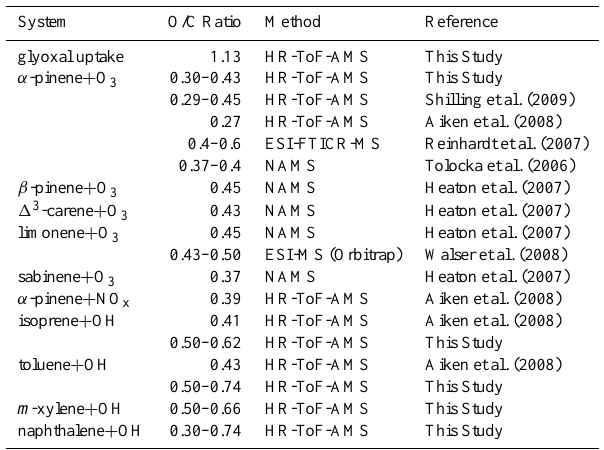
Table 3. O/C ratios of various laboratory SOA systems.